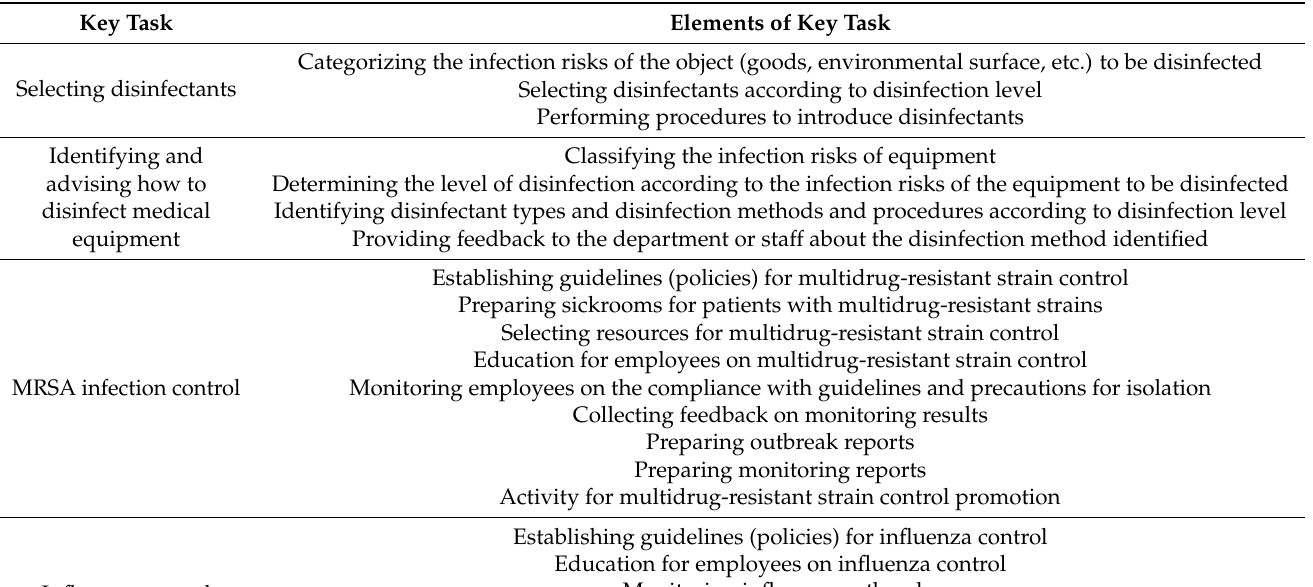
Table 2. Elements of key